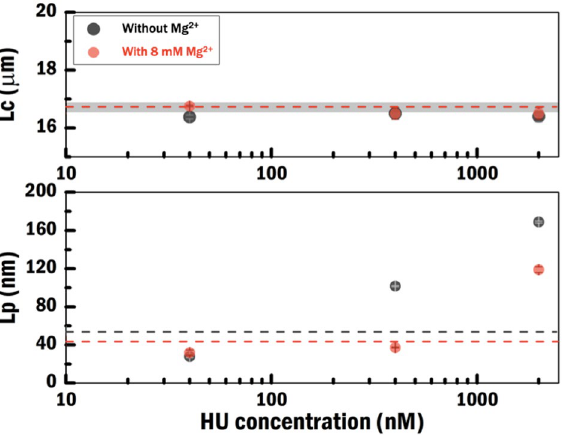
Figure 3. Contour length (Lc) and persistence length (Lp) as a function of protein concentration. Grey and red solid circles represent values obtained for the HU–DNA complexes measured without and with 8 mM Mg 2+ , respectively. Thin dashed lines represent the values without HU protein. Lc values without HU protein are overlapping in both salt conditions. Thick shaded line represents the error bar. Data points for a concentration of 40 nM HU were obtained by fitting force-extension curves from both Alexa-555-labelled and wild-type HU– DNA complexes. All data points in the figure were obtained by fitting a Gaussian function to Lp and Lc